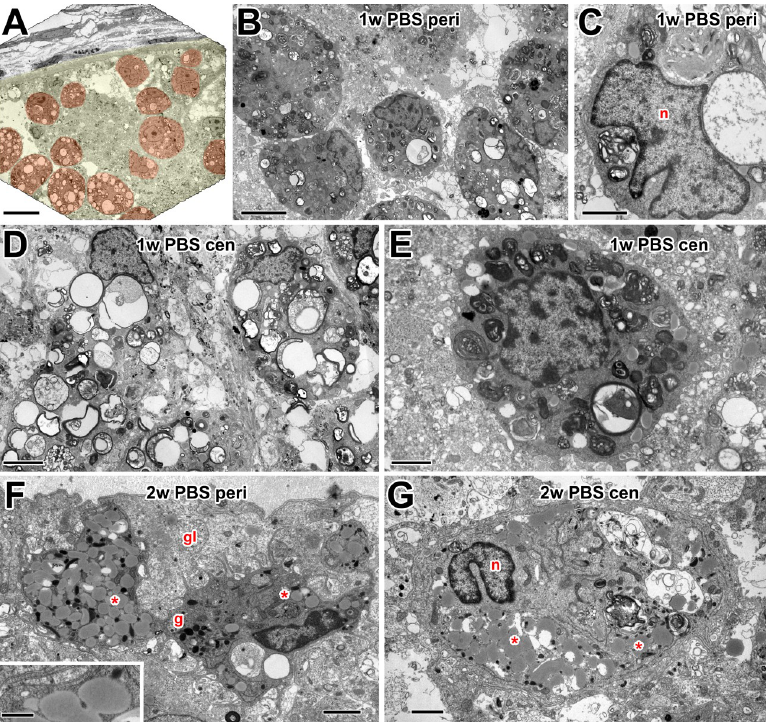
Fig 4. Electron microscopy of macrophages in PBS controls. (A) Low power electron micrograph of the optic nerve periphery at 1 w after injury, with a pale yellow overlay indicating the nerve and pale red overlay indicating numerous macrophages within it. (B) Peripheral macrophages containing a variety of multilamellar and multivesicular bodies, products of phagocytic activity. (C) Macrophage with an irregular nucleus (n) and large debris-filled multilamellar bodies. (D) Centrally located macrophages containing large vacuoles with apparent remnants of degenerating axons. (E) Central, smaller (possibly microglia) cell with multilamellar and multivesicular bodies. (F) Peripheral macrophages at 2 weeks, located within the glia limitans (gl). Some vacuoles with axonal debris are present but the cytoplasm also contains lipid inclusions (asterisks) and dark granules (g). Inset: high magnification view of putative lipid inclusions, showing lack of a bounding membrane. (G) Large central macrophage with a bilobed nucleus (n) at 2 weeks, containing a mixture of vacuoles with axonal debris, and lipid inclusions (asterisks). Scale bar: 20 μ m in A; 5 μ m in B, D; 2 μ m in C, E, F, G; 0.5 μ m in